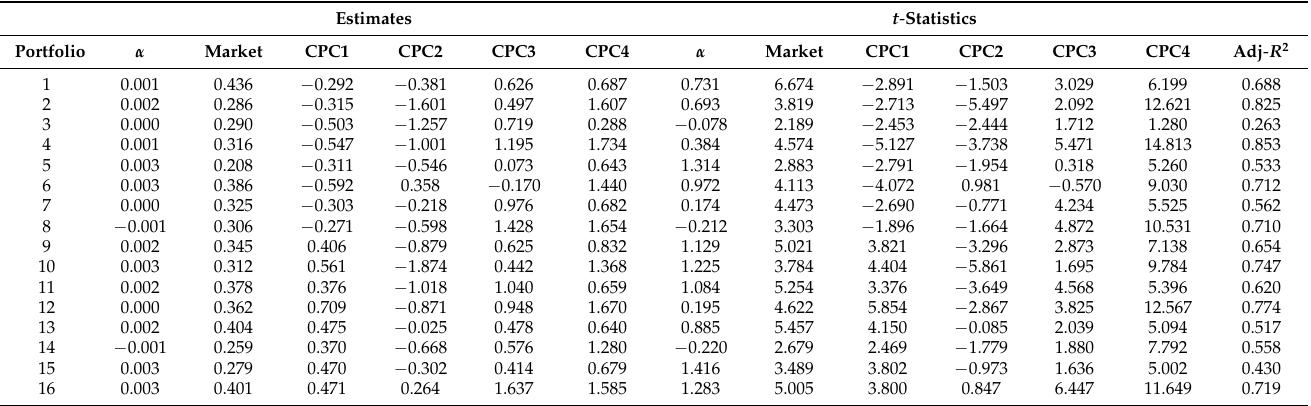
Table 9. Results for Time-Series estimation of Model